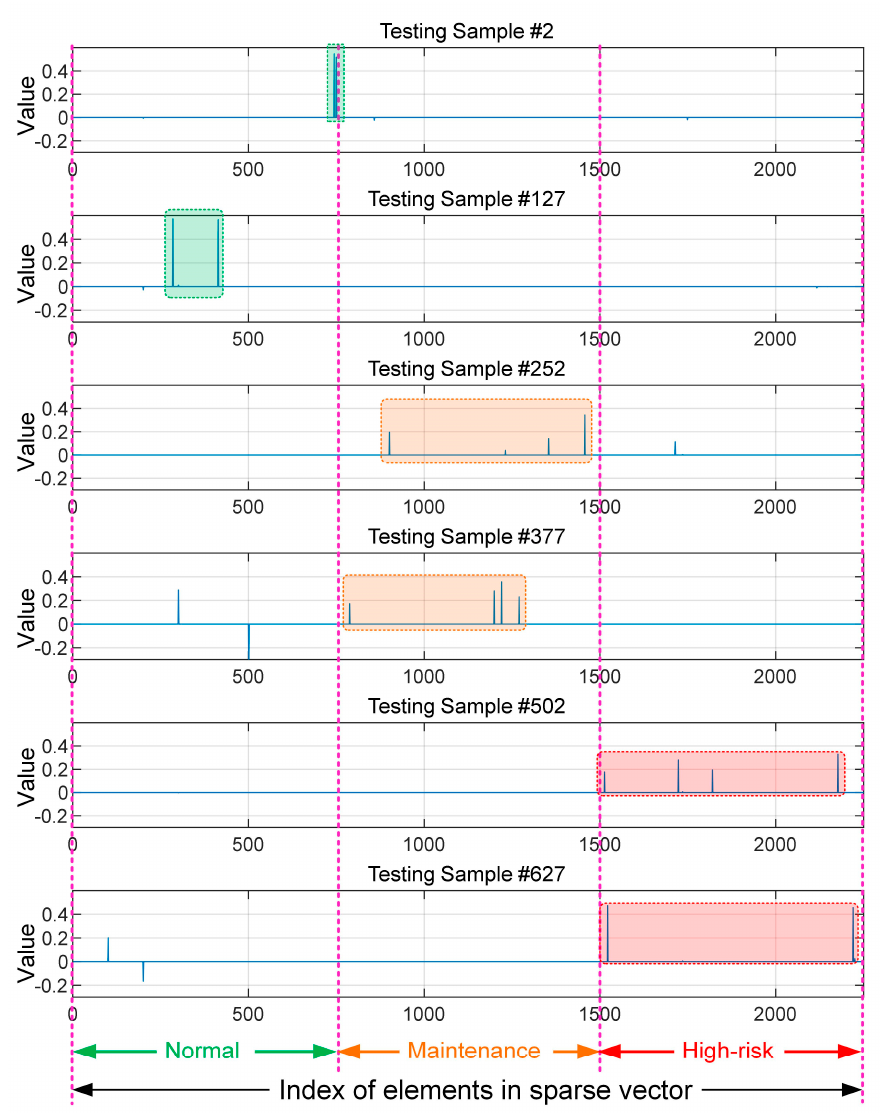
Figure 14. LGPG: sparse vectors of testing samples #2, #127, #252, #377, #502, and #627. Finally, three partial sparse vectors were derived from the original sparse vector ˆ r .